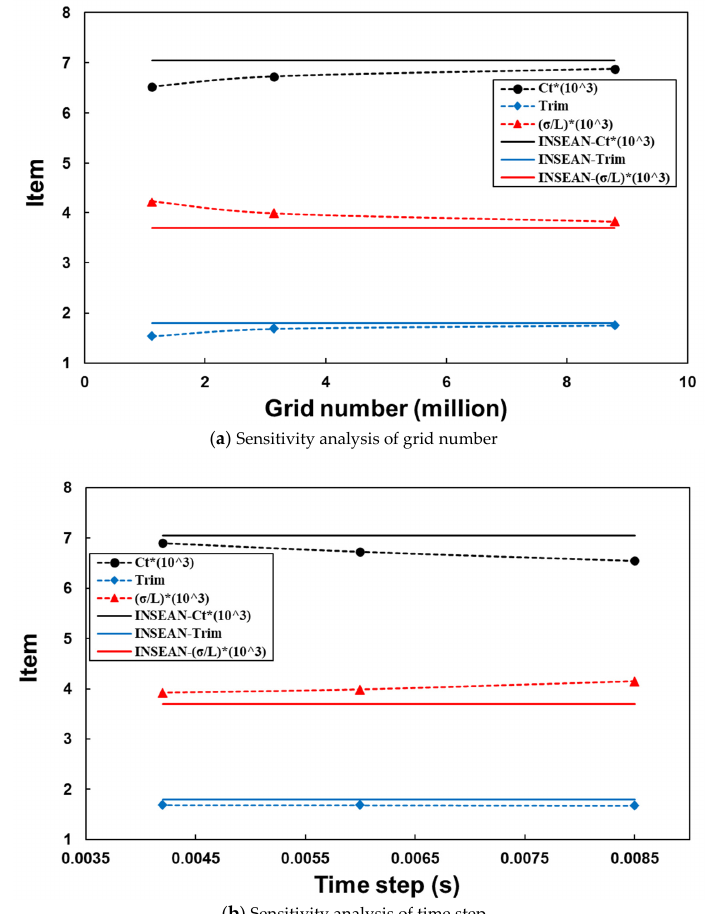
Figure 8. Sensitivity analysis of grids and time steps.